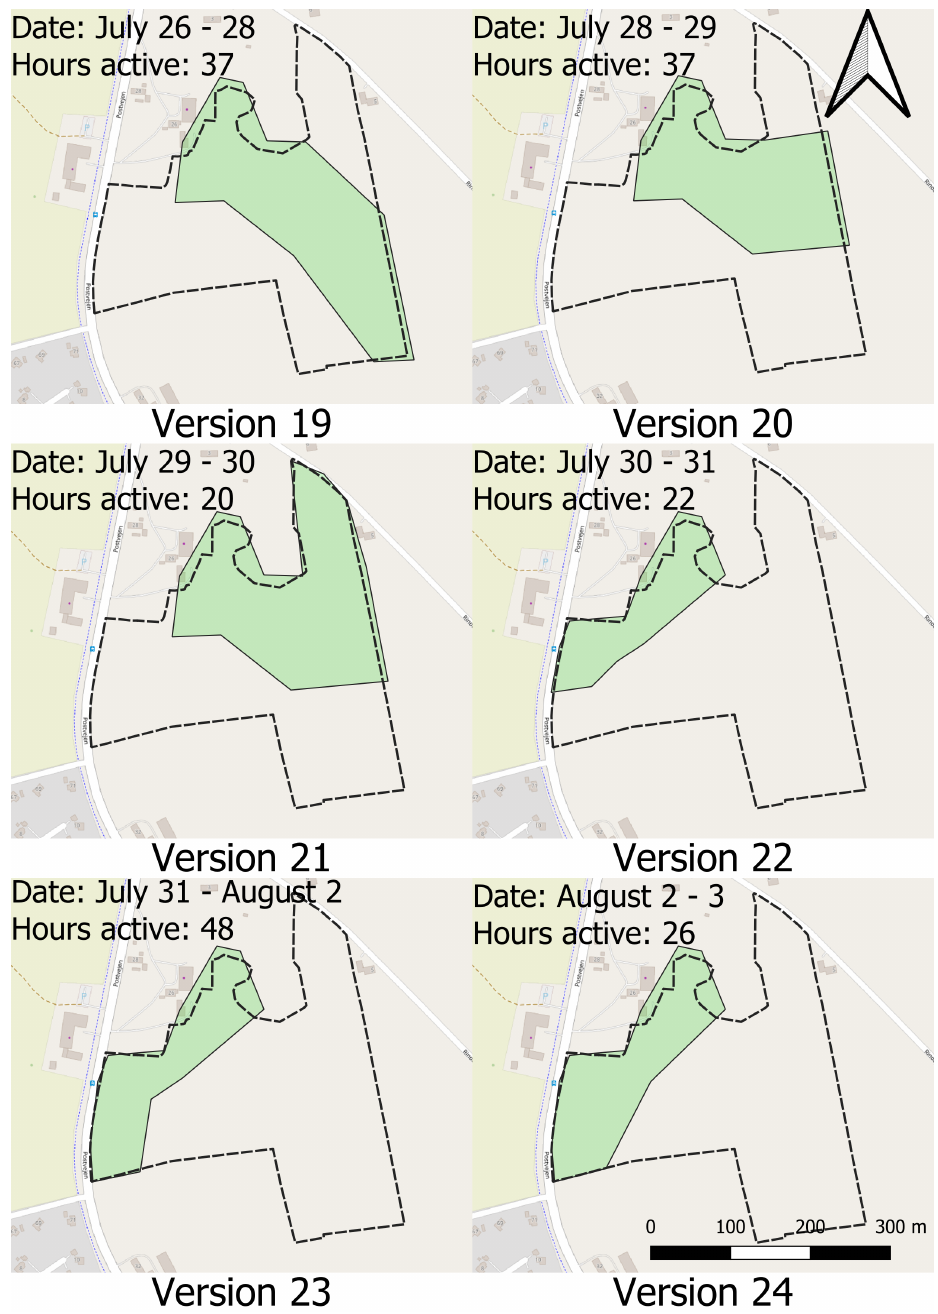
Figure A4. Virtual enclosure version 4 dating from 26 July to 3 August. The dashed black line represents the physical fence surrounding the 8.2 ha grazing area. The marked green area represents the virtual enclosure. Only virtual enclosures active for more than 12 h were included. The coordi- nates of the upper left corner of the map frame are 55°25 (cid:48) 23.131 (cid:48)(cid:48) E 8°23 (cid:48) 53.531 (cid:48)(cid:48) N. Map data from OpenStreetMaps